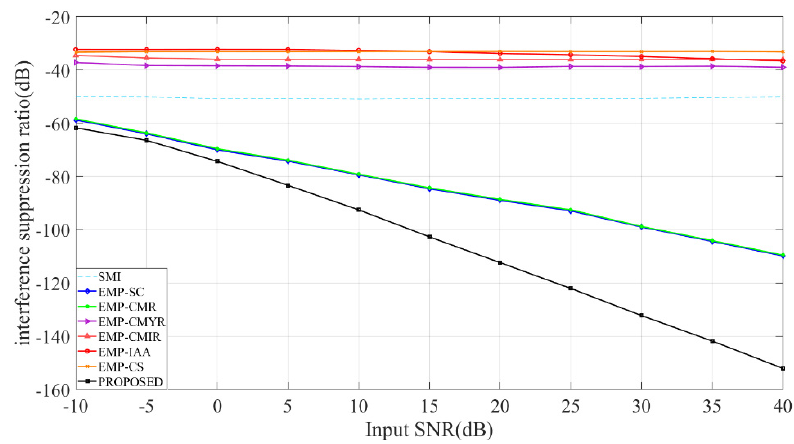
Figure 6. Analysis of the impact of input SNR on ISR.